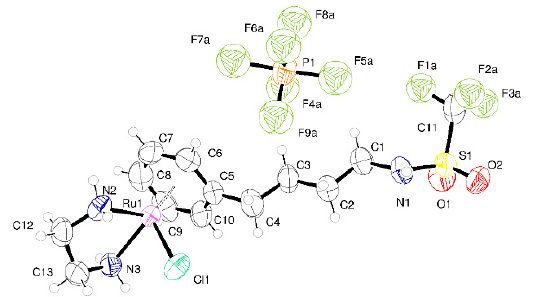
Figure 5. Asymmetric unit of 5 with atoms shown as 50% displacement parameters (small-scale disorder in the anion and CF 3 group are not shown).